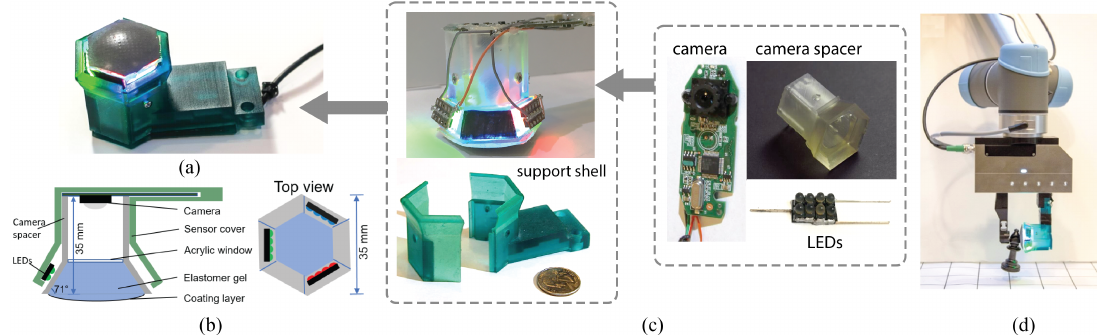
Figure 12. The new GelSight fingertip sensor introduced in [29] (©2017 IEEE). The sensor has three LED arrays of different color to illuminate the elastomer surface from a tilted angle of 71°, and a USB web cam to capture real-time image from the sensor. ( a ) the picture of the sensor; ( b ) the schematic diagram; ( c ) the parts of the sensor; ( d ) the sensor mounted on a WSG-50 parallel gripper (Weiss Robotics, Ludwigsburg,